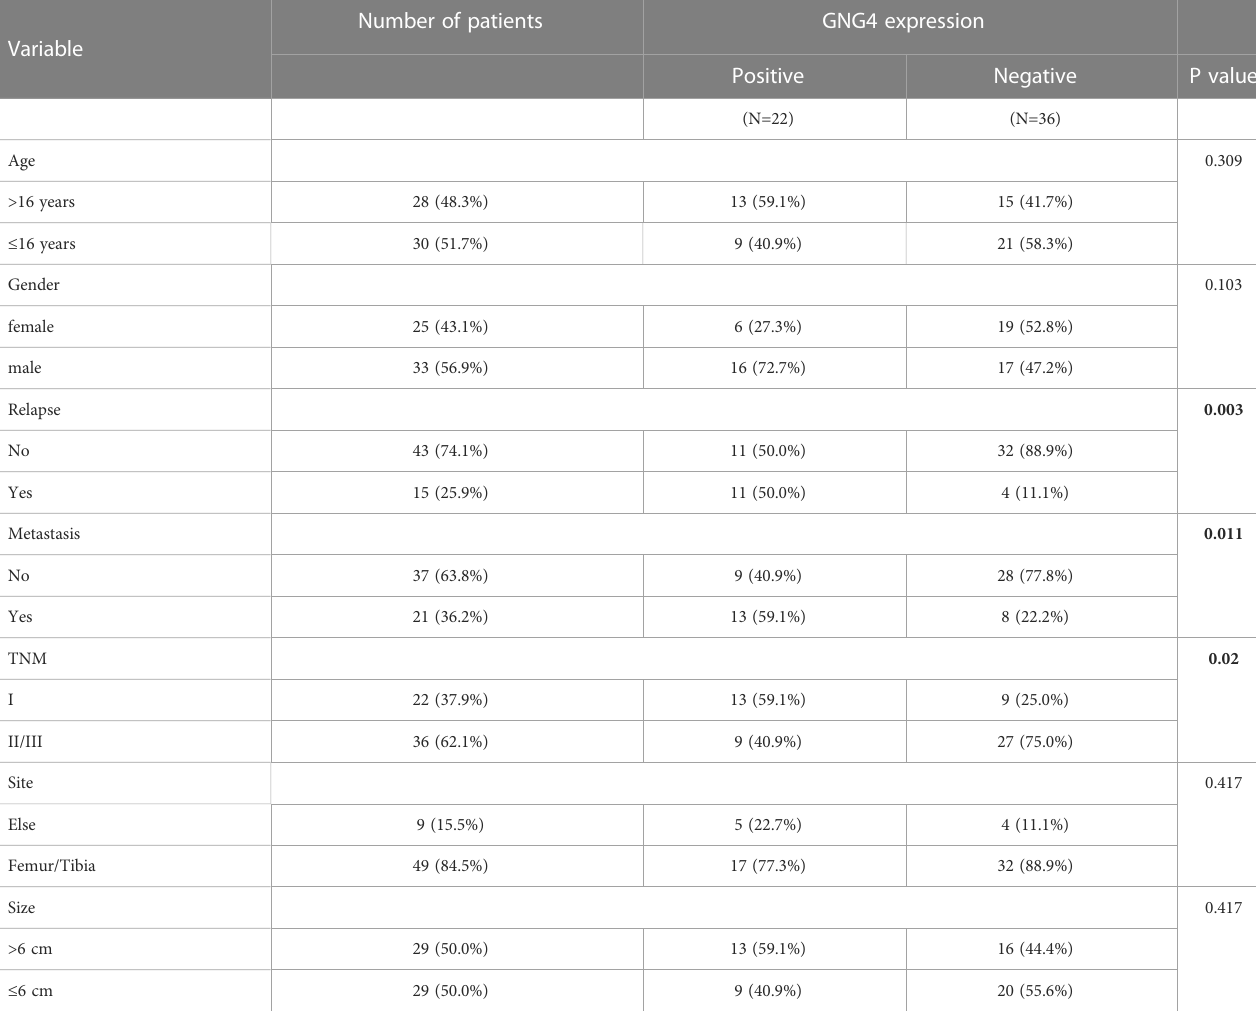
TABLE 3 Associations between clinicopathological characteristics and GNG4 in the external validation cohort.